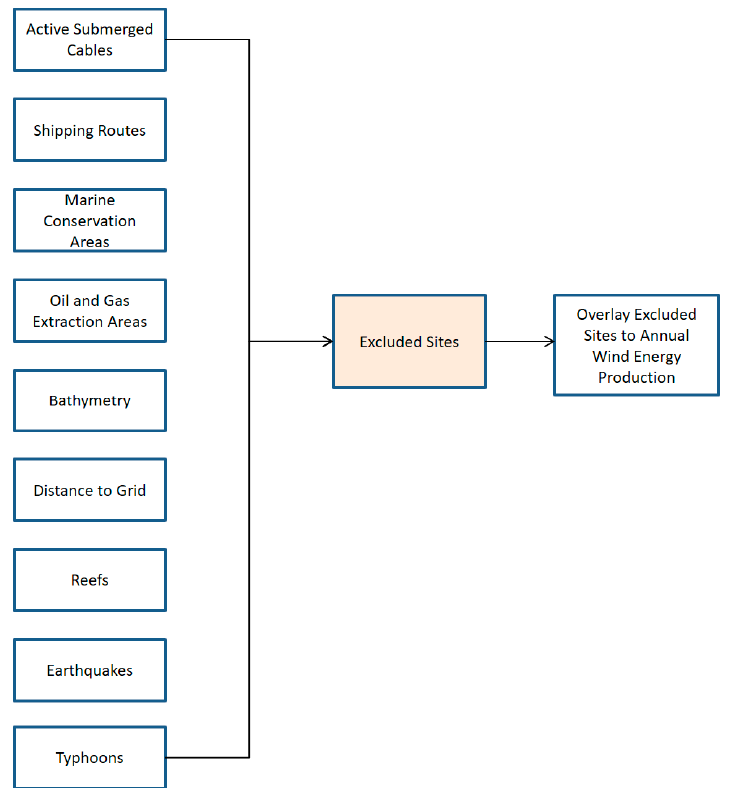
Figure 2. Detailed exclusion analysis.